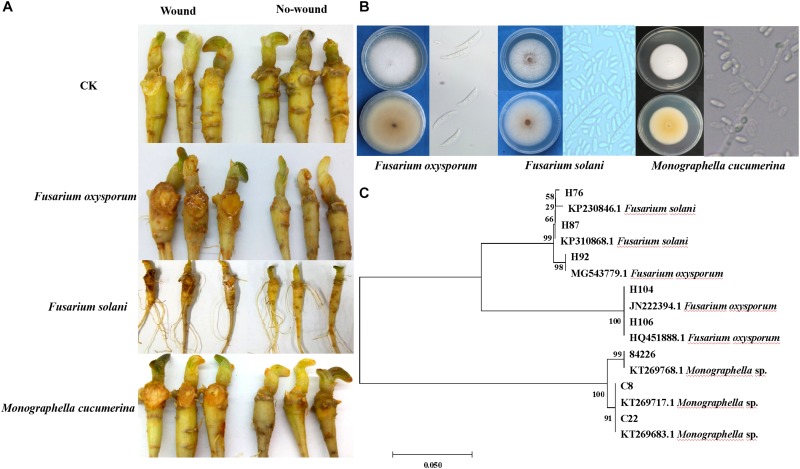
Identification of pathogens causing sanqi rot root and pathogenicity tests. Pathogenicity tests were performed on sanqi roots in vitro
(A). Colony morphology and conidial characteristics of Fusarium spp. and Monographella cucumerina
(B). Hierarchical clustering of ITS genes of pathogens (C).